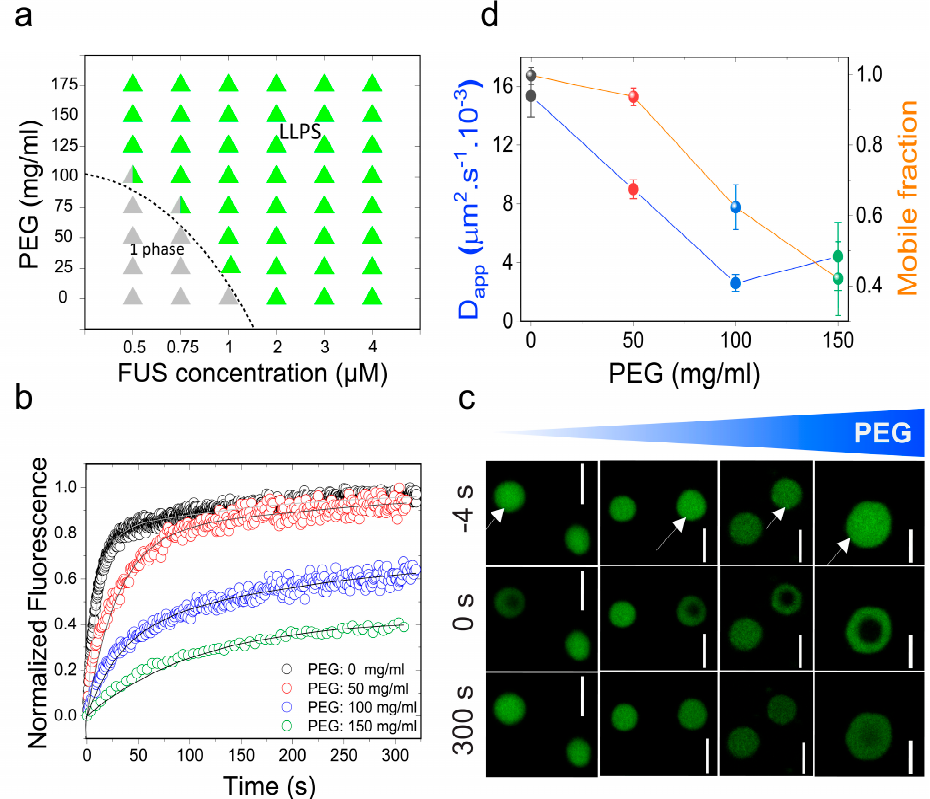
Figure 1. Molecular crowding facilitates full-length fused in sarcoma (FUS FL ) liquid–liquid phase separation (LLPS) and tunes protein droplet viscoelastic properties. ( a ) Isothermal phase diagram of FUS-polyethylene glycol (PEG) 8000 mixtures. The dotted line indicates the liquid–liquid phase boundary. ( b ) Fluorescence recovery after photobleaching (FRAP) plots of FUS (10 µ M) condensates at various concentrations of PEG8000. ( c ) Confocal fluorescence microscopy images corresponding to the data in Figure 1b are shown. Scale bar = 4 µ m. Negative time implies droplets before bleaching. ( d ) An coefficients (D app ; left axis, blue line) and the fraction of the mobile phase (right axis, orange line)